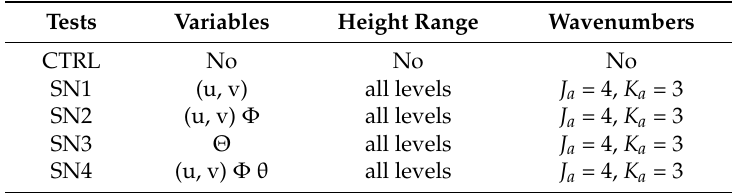
Table 2. Experimental design of sensitivity tests.